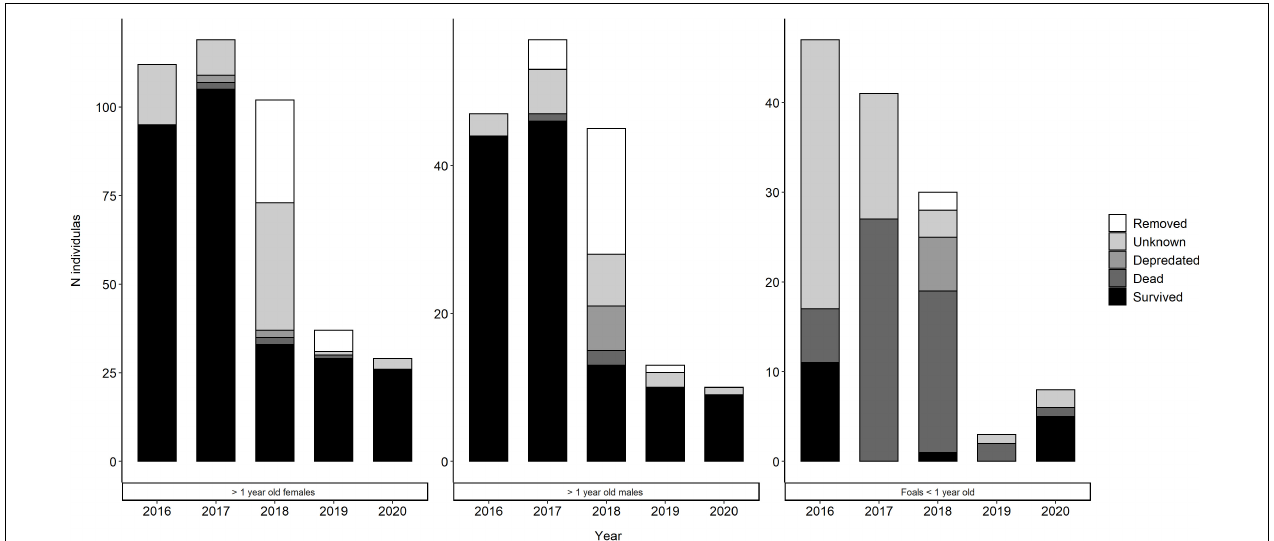
FIGURE 1 | Population changes by age class for females and males ( > 1 year old) and foals ( < 1 year old), representing the individuals that survived and disappeared in SA from 2016 to 2021. Individuals were categorized as “Dead” if they were identified in the wolves’ scats or disappeared during the breeding season when removals did not take place; “Depredated” if the carcasses were found in a kill site (Freitas, 2019); “Unknown” if the horse had disappeared outside the breeding season period and its death had not been confirmed; and “Removed” if we could confirm they were taken from the mountain by owners or locals.